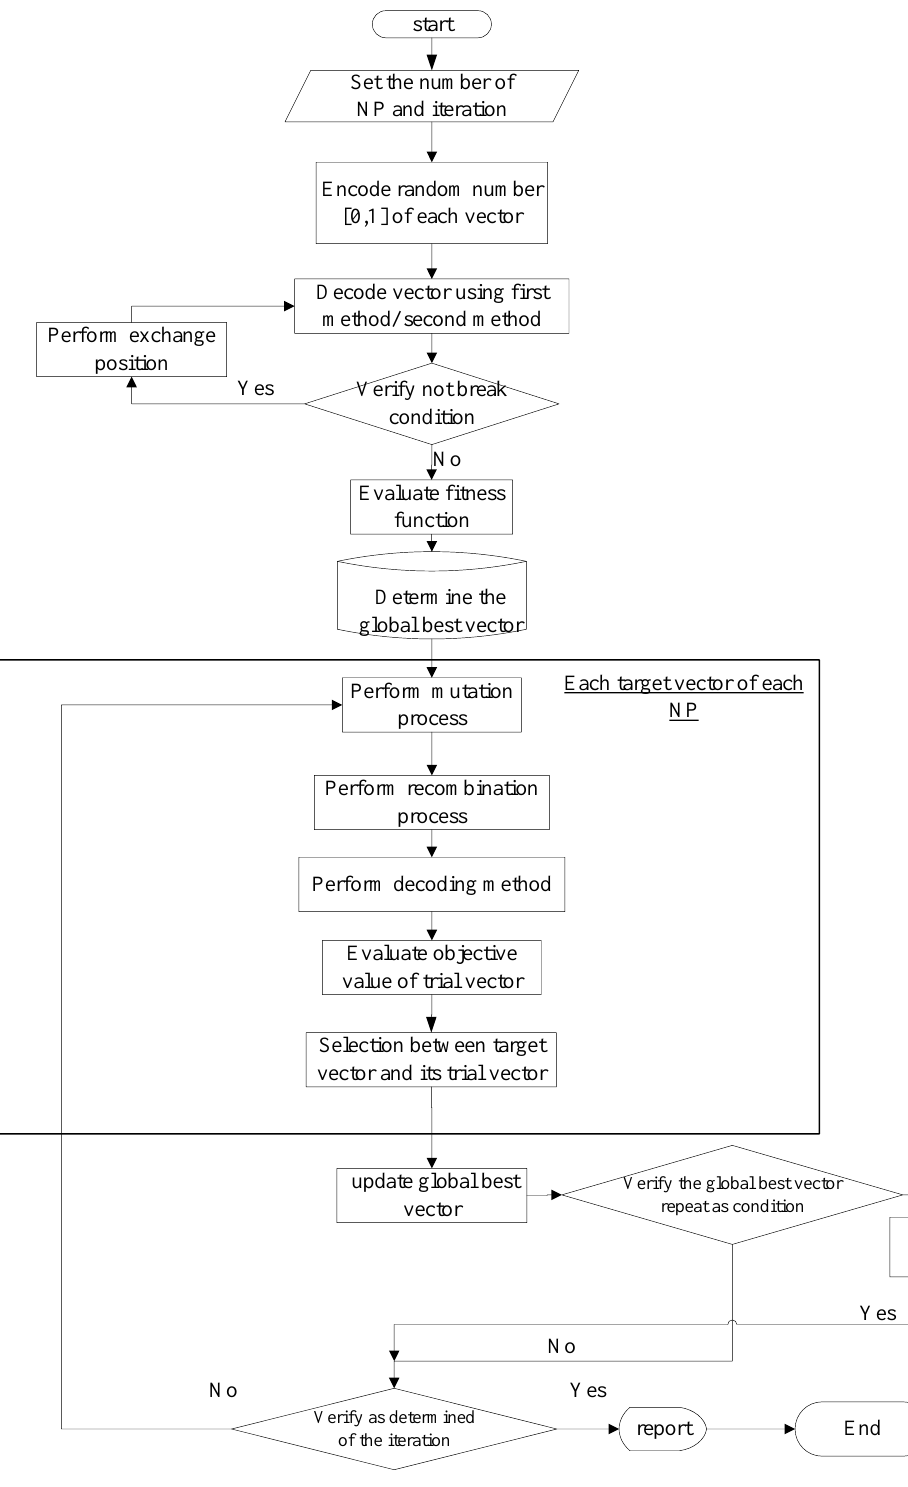
Figure 2. Modified differential evolution (MDE) algorithm.